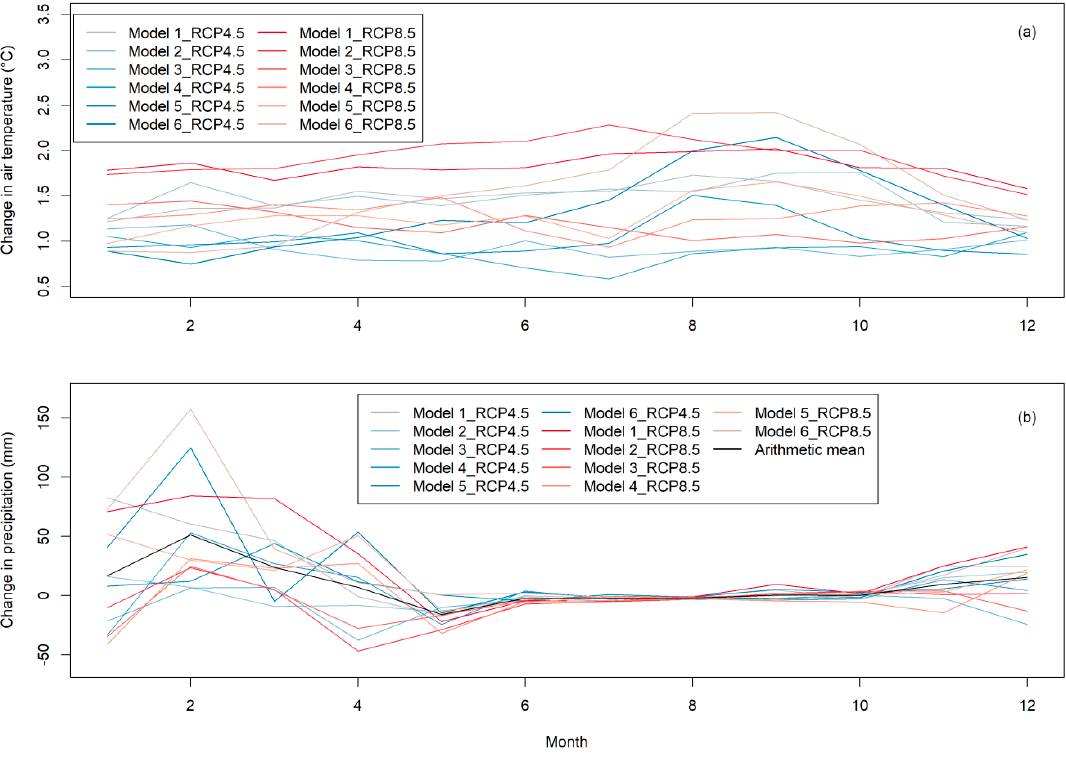
Figure 8. Climate change signal among the bias-corrected historical model runs for ( a ) mean temperature (1979–2005) and the bias-corrected scenarios RCP4.5 and RCP8.5 (2010–2060), and ( b ) precipitation changes among the bias-corrected historical model runs (1951–2005) and the bias-corrected scenarios RCP4.5 and RCP8.5 (2010–2060). All values represent the monthly spatial averaged temperature and precipitation for the given periods, respectively.